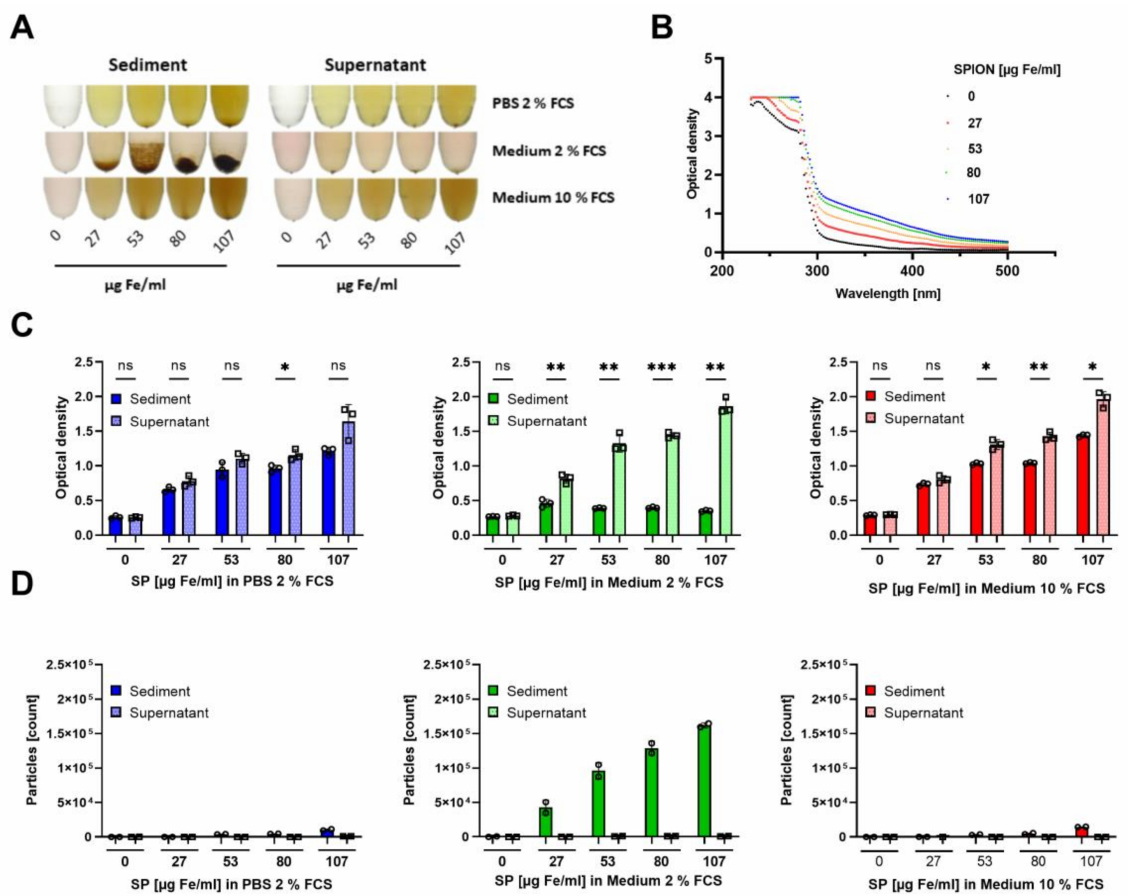
Figure 1. Colloidal stability of SPIONs in various media. SPIONs were incubated overnight in PBS with 2% FCS or RPMI cell culture medium containing 2% or 10% FCS, respectively. ( A ) Macroscopic pictures of SPIONs diluted in PBS supplemented with 2% FCS or T cell medium with 2% or 10% FCS, respectively. ( B ) Spectrum of SPIONs diluted in RPMI with 10% FCS. ( C , D ) T cell medium with 10% FCS is depicted in red, while T cell medium with 2% FCS is shown in green. PBS supplemented with 2% FCS is depicted in blue. ( C ) Optical density at 320 nm of the supernatant of sedimented or resuspended samples. ( D ) Supernatant or sediment was analyzed in flow cytometry for agglomerations. Shown are the mean values of triplicates ( C ) or duplicates ( D ) with standard deviations. Significances were calculated using unpaired t-test with Welch’s correction; * p ≤ 0.05; ** p ≤ 0.01; *** p ≤ 0.001. ns: not significant, SP: